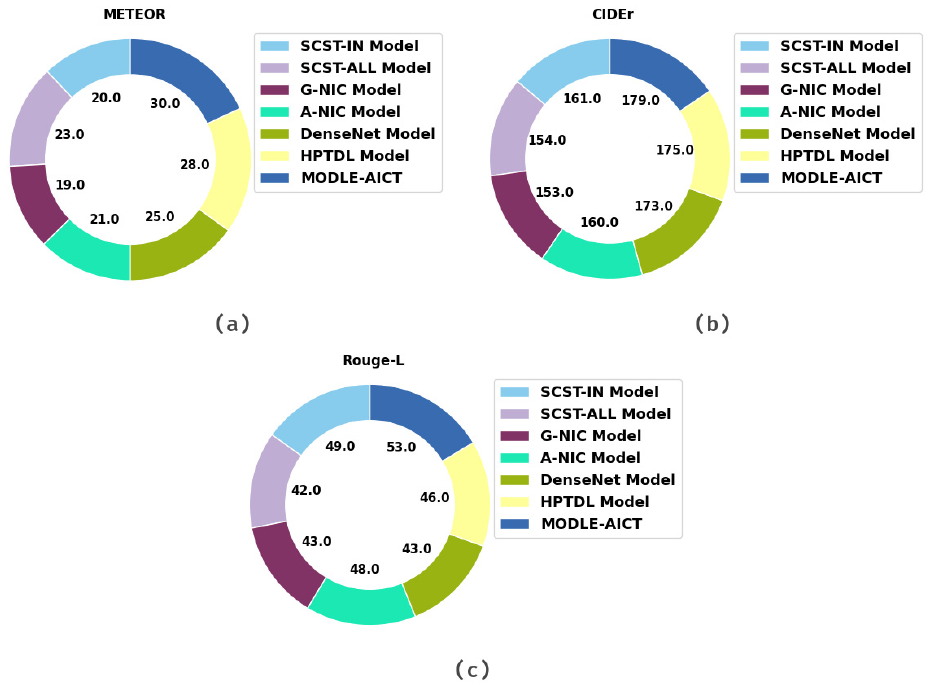
Figure 4. Result analysis of MODLE-AICT algorithm on Flickr8K dataset ( a ) METEOR, ( b ) CIDEr, and ( c ) Rouge-L. Table 3. Classification analysis of MODLE-AICT algorithm with approaches on Flickr8K dataset.